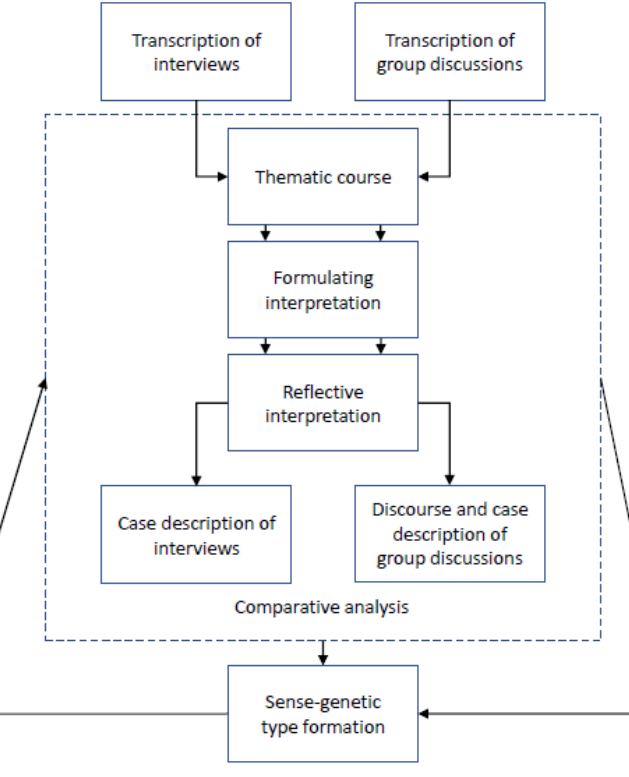
Figure 2. Exemplified steps of analysis within the documentary method of